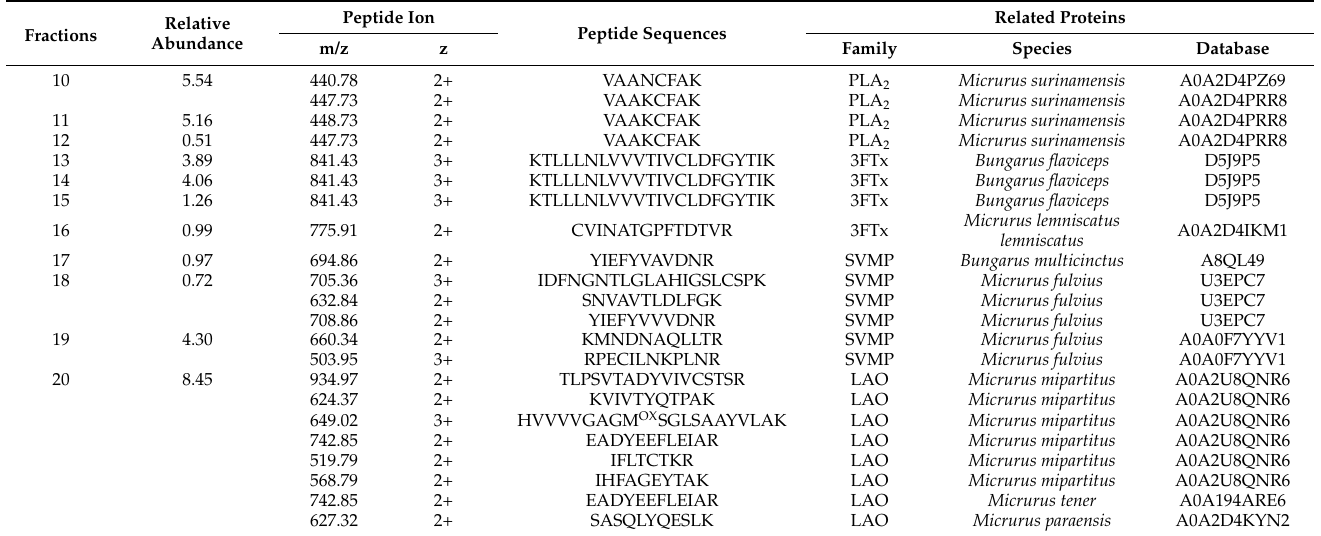
( B ) Figure 5. Proteomic insights into two Ecuadorian coral snake venoms. The pie charts represent the relative abundance of protein families found in the venom proteome of ( A ) M. helleri and ( B ) M. mipartitus . The relative abundance of protein families is expressed as % of the total venom toxin content, estimated based on chromatographic peak areas. UNK: unknown/unidentified. 3. Discussion Micrurus (coral snake) species belong to the New World elapids, a monophyletic group of small, coloured, extremely venomous, and broadly-occurring snakes [34]. They are considered ideal organisms for ecological, evolutionary, pharmacological, physiolog- ical, phylogenetic, and proteomic studies [29]. Their ability to produce small quantities of venoms has limited the manufacturing of antivenoms as well as structural, functional, and immunological research [35]. The first integrative venom proteomics using coral snake was developed in 2008 [36], but most of the quantitative estimation of proteome compo- sitions were published in the last 10 years [27,30]. Even so, a significant number of Mi- crurus venoms have remained inaccessible to studies [29]. The boom of proteomic approaches has led to a greater understanding of the bio- chemical arsenal of venoms from New World coral snakes [29,30,37]. The analysis of the distribution and abundance of toxin families has revealed two intriguing divergent com- positional patterns: PLA 2 -rich and 3FTxs rich venoms [24]. In brief, a general trend marked by the polarization of venom phenotypes along Micrurus north–south dispersal has been observed [30]. The abundance of PLA 2 is extremely high in venoms from coral snakes in- habiting the North, while in most southern species, this value is significantly reduced and compensated by a high expression of 3FTxs [25]. So far, proteomic analyses of coral ven- oms are still limited, and the challenging 3FTx/PLA 2 dichotomy puzzle in Micrurus needs further pieces of information to complete a comprehensive picture.